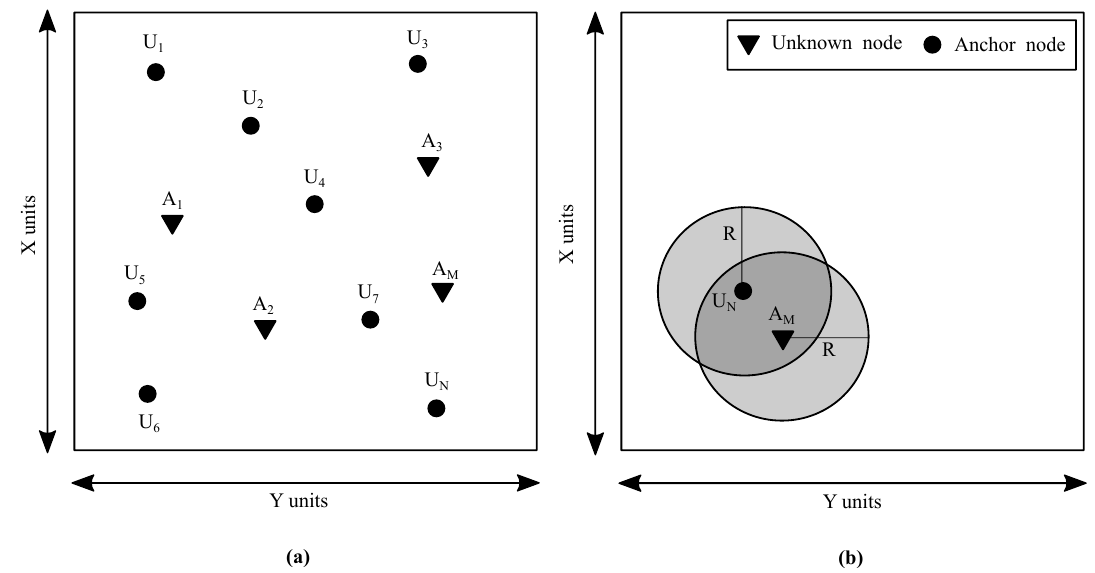
Figure 1. ( a ) System architecture with M anchor (in black-filled circle) and N unknown nodes (in black-filled triangle) deployed in X × Y square units area. ( b ) Sensor nodes with transmission range R distance